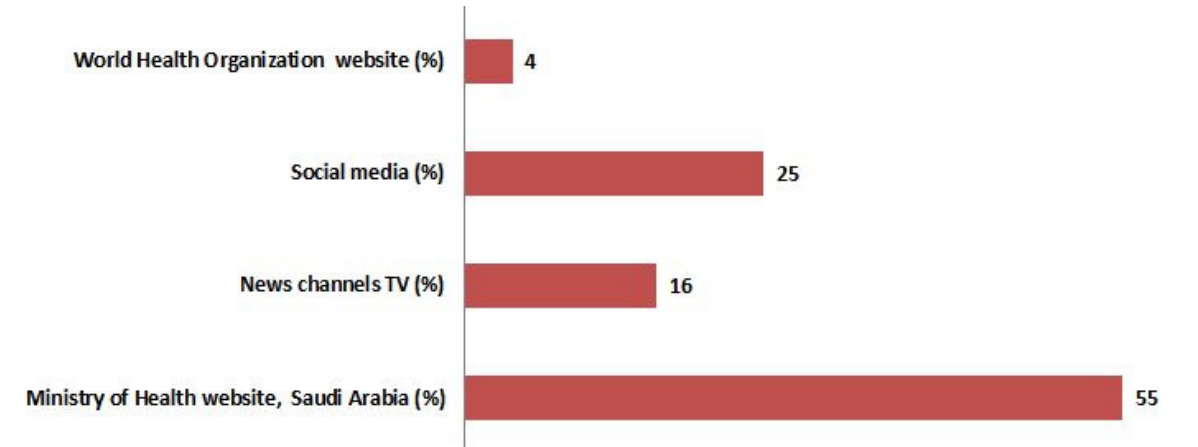
Figure 3. Details of the source of information utilized by the Saudi Arabian population participated in the study.